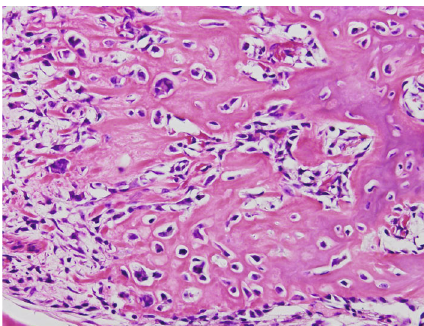
Figure 6: Photomicrograph showing trabeculae with low calci fi cation spread radially in the periphery of the tumor. Tumor cells with mild atypia are present densely, with partial cartilage ossi fi cation (hematoxylin-eosin stain, ×